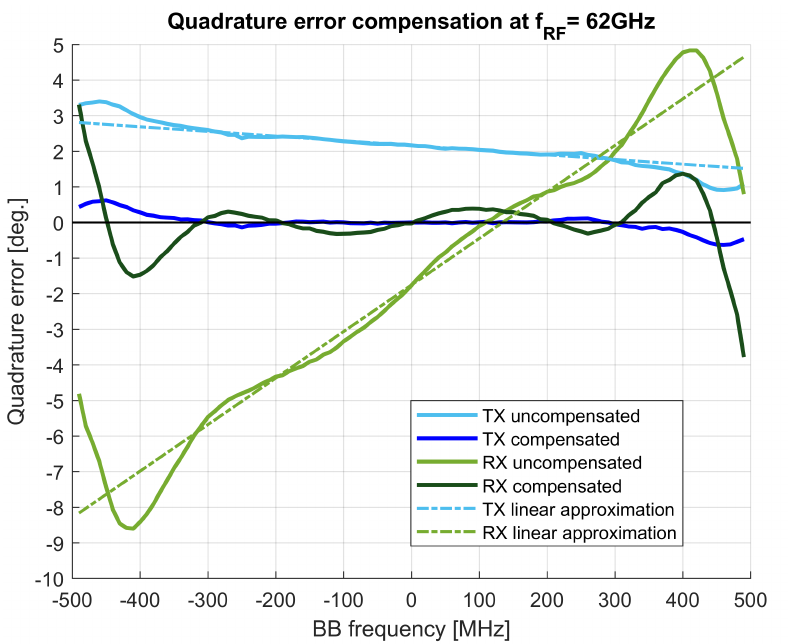
Figure 6. Quadrature error at TX and RX sides, with and without digital